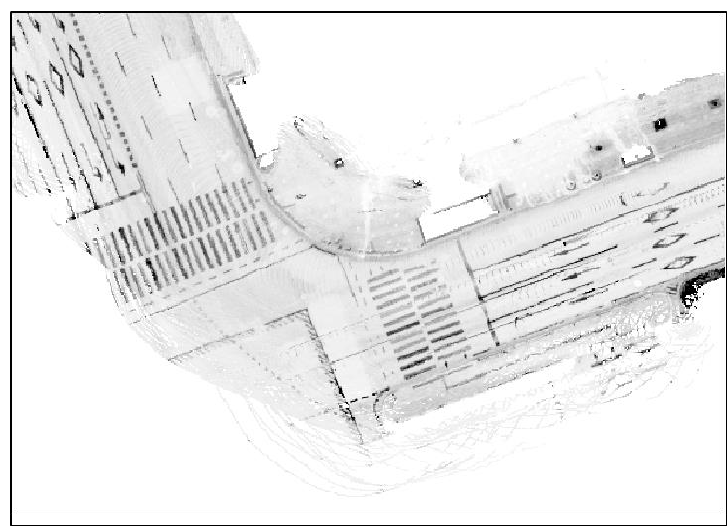
Figure 6. Generated road reflectivity map (before plane extraction).